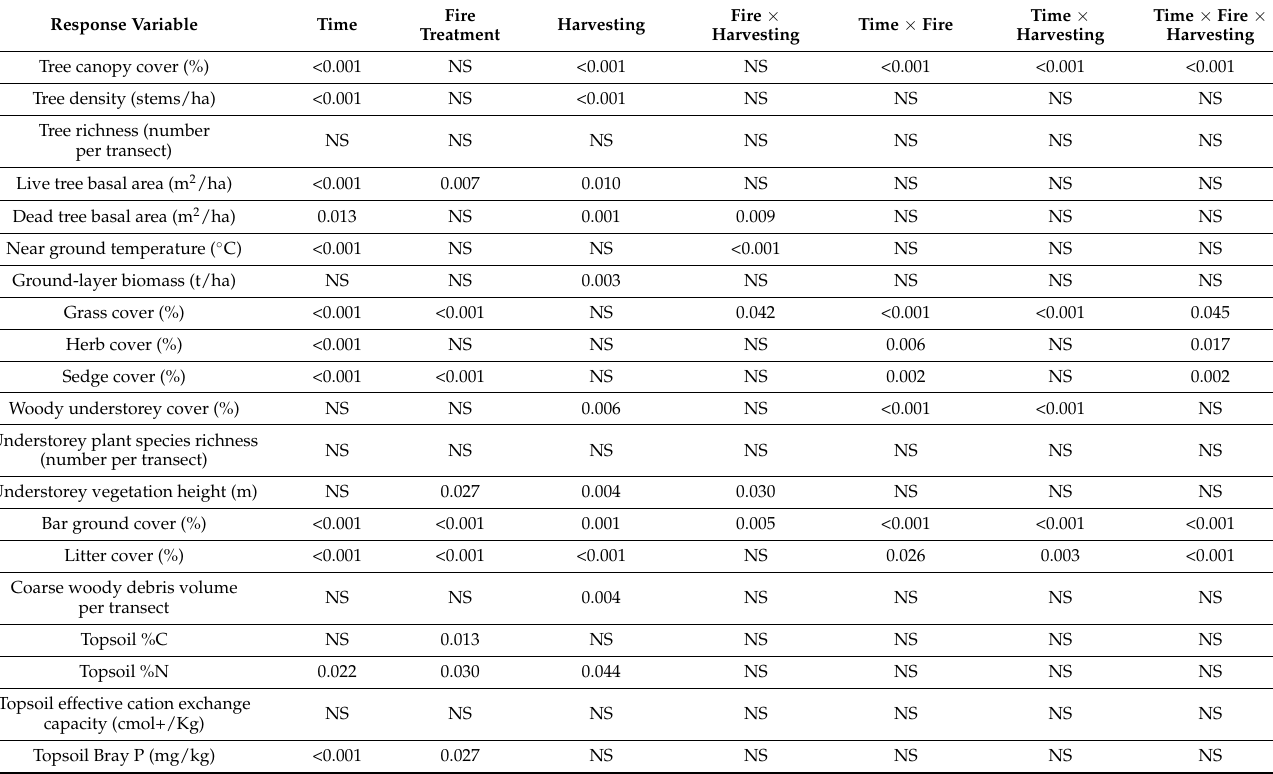
Table A1. Summary of p -value significance based on repeated measures analysis of variance (ANOVA) or a REML mixed models for response variables measured at the Bauple long-term fire experiment from 2015 to 2018. NS, not significant ( p > 0.05). Fire treatments were annual and triennial prescribed fire and no prescribed fire (wildfire only), timber harvesting treatments were harvested or not harvested in